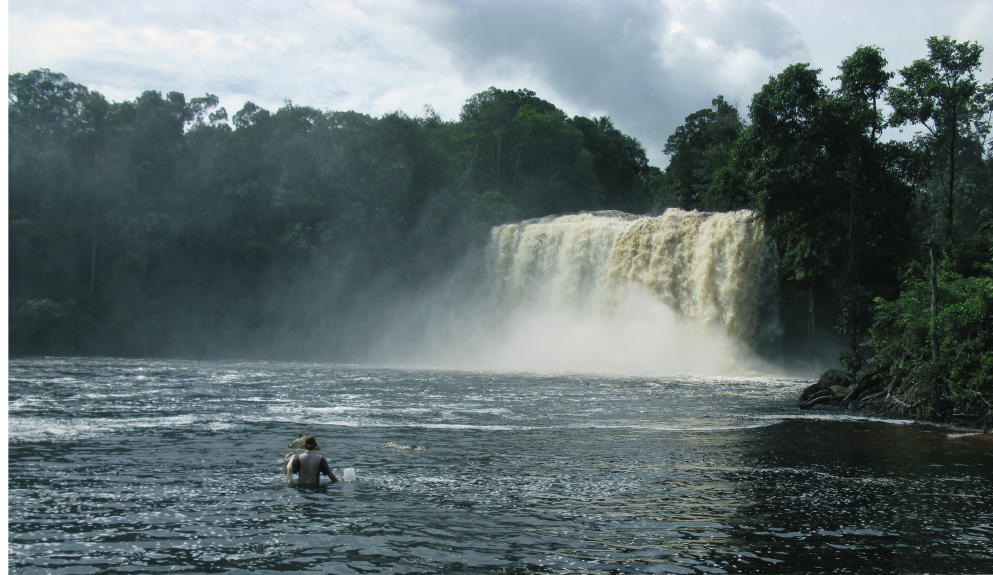
Fig. 5. Rio Curuá, above the great falls, showing one of the collection sites of Leporinus